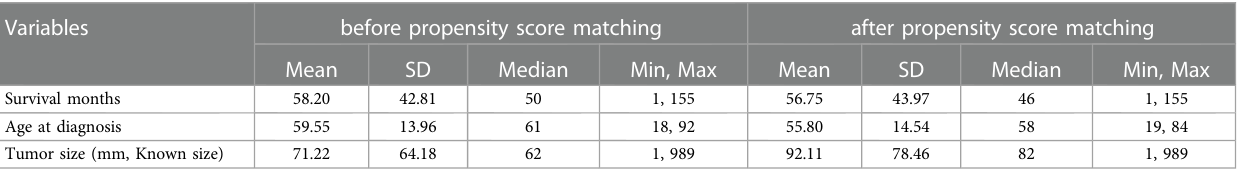
TABLE 4 Descriptive statistics for the entire cohort and matching cohort.